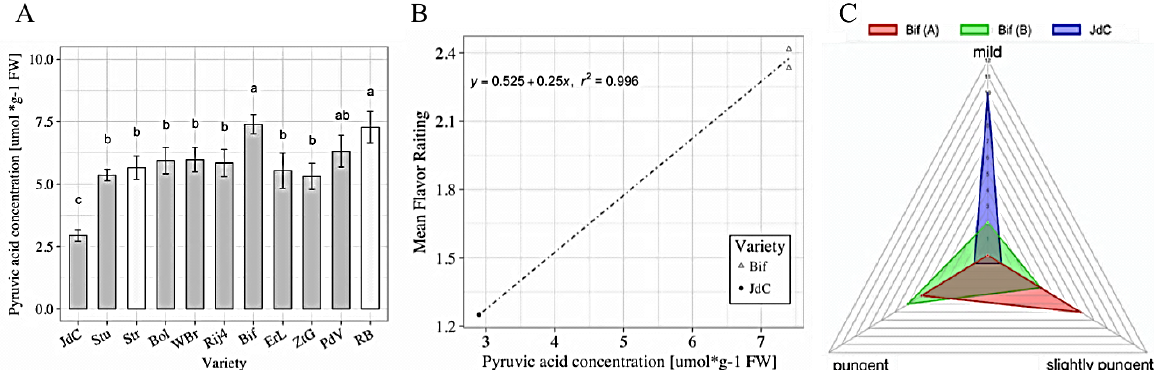
Fig. 4: Pungency of onions. A: Enzymatically produced pyruvic acid. Data are mean ± SE, n = 4. Significant test by Tukey’s HSD (p < 0.05) are indicated by different letters. Control varieties Sturon and Red Baron are highlighted as blank barplots. Jaune des Cévennes (JdC), Stunova (Stu), Sturon (Str), Bolstar (Bol), Wiener Bronzekugel (WBr), Rijnsburger 4 (Rij4), Birnförmige (Bif), Erfurter Lager (ErL), Zitauer Gelbe (ZtG), Paille des Vertus (PdV), Red Baron (RB). FW = fresh weight. B: Relationship between pungency perception and enzymatically produced pyruvic acid by two onion varieties Birnförmige (Bif), and Jaune des Cévennes (JdC). Regression coefficients are significantly different from zero (p < 0.05). Flavor rating scale: 1 = mild, 2 = slightly pungent, 3 = pungent. C: Radar chart of the sensory analysis, the samples of the onion varieties Birnförmige: Bif A (red), Bif B (green) and Jaune des Cévennes: JdC (blue), were categorized as mild, slightly pungent and pungent as described in the radar